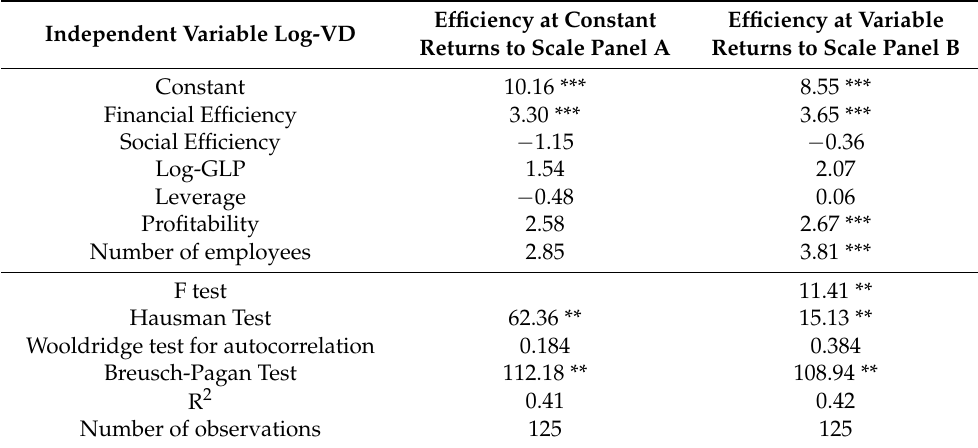
Table 11. Robustness check by comparing the impact of efficiency estimate at a constant return to scale and the variables return to scale on the level of voluntary